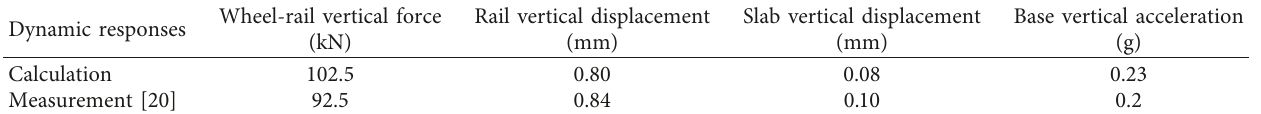
Figure 2: The time history curve of wheel-rail vertical force and base vertical acceleration. (a) Wheel-rail vertical force. (b) Base vertical acceleration. Table 2: The maximum values of calculated and measured dynamic